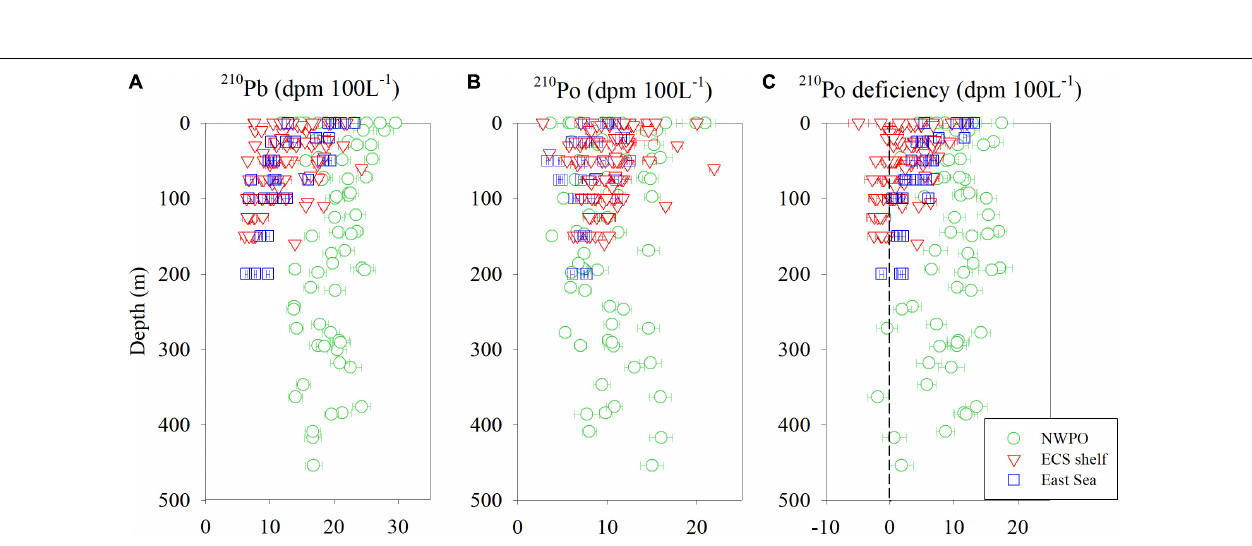
FIGURE 1 | Locations of the sampling stations in this study and previous studies in the northwestern Pacific Ocean (NWPO) and its adjacent marginal seas.